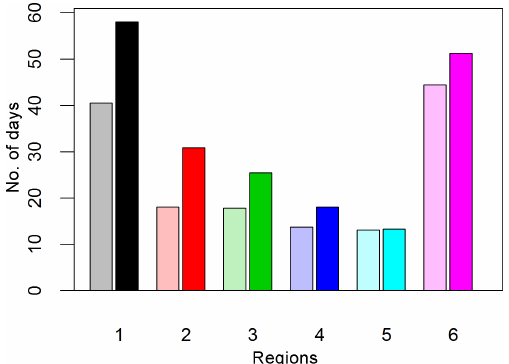
Figure 8. Number of compound cold and wet extremes in winter (DJF) (Ta < 10th percentile and Pa > 75th percentile), 1971–2000 (light colors) and 2021–2050 (dark colors), ensemble mean. The coloring corresponds to the regions in Fig.